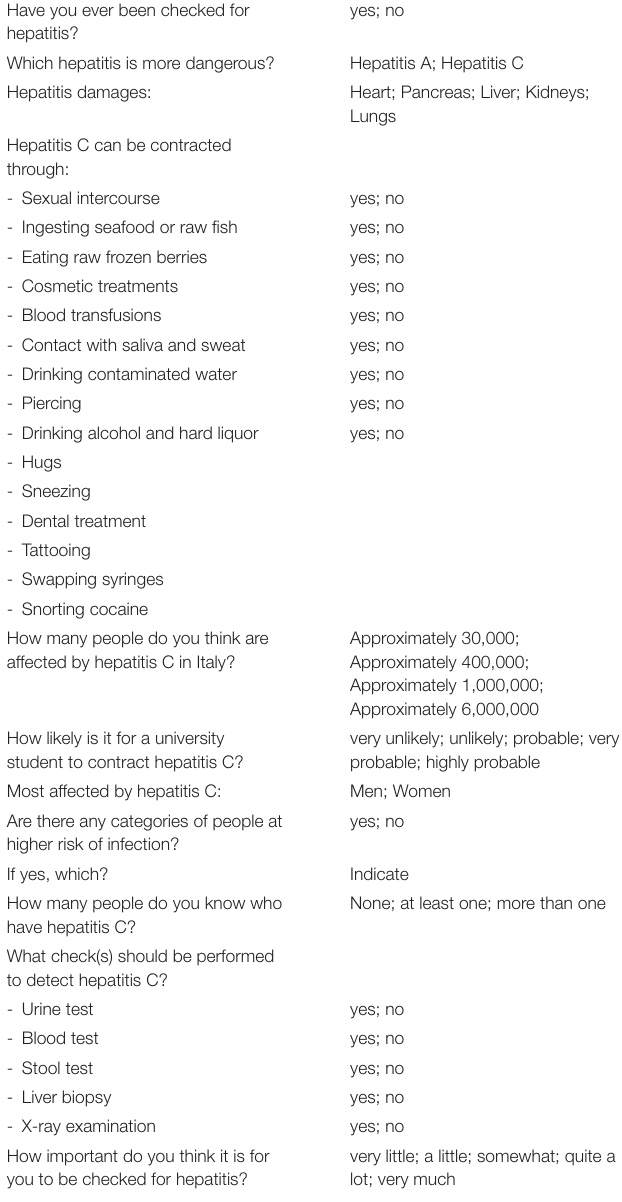
TABLE 3 | Knowledge form about hepatitis